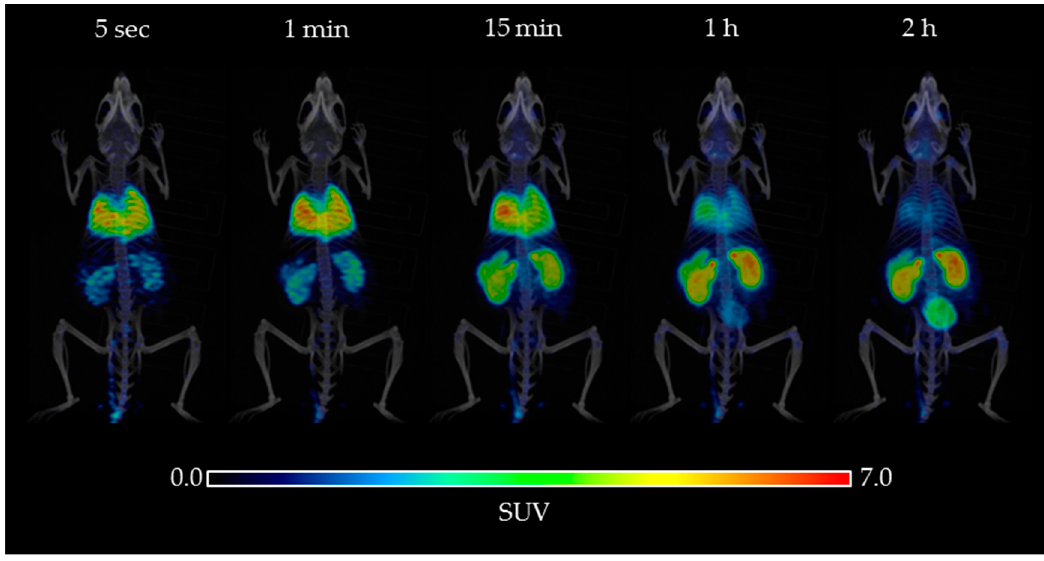
Figure 4. [ 18 F]FEPPA 3D PET/CT imaging from tracer injection to 120 min after in a C57BL/6 mouse. Image at 5 s, 1 min, 15 min, 1 h ,and 2 h post-injection.